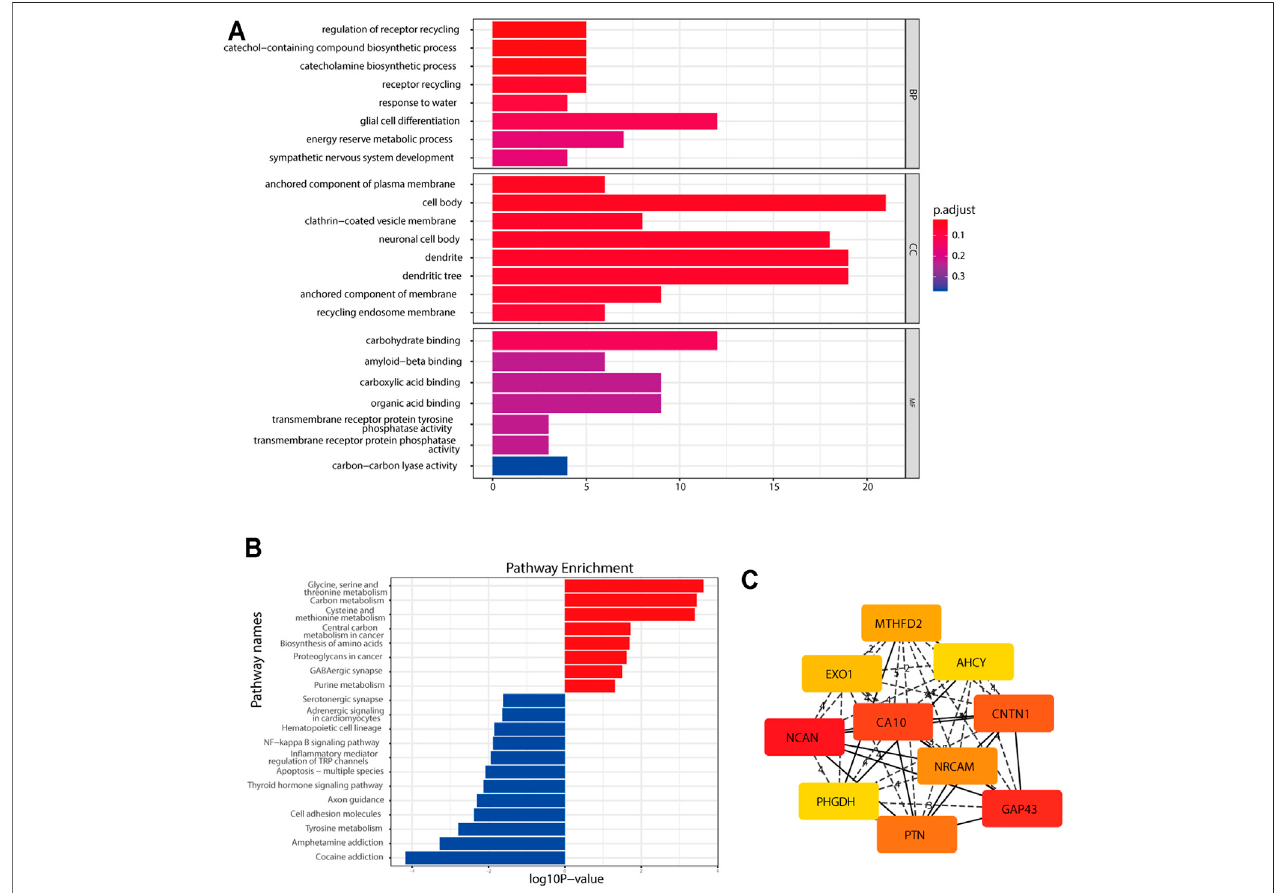
FIGURE3 | Functional enrichmentanalysis ofthe DEGs. (A) GOanalysisof theDEGs. (B) KEGG pathway enrichment analysis ofthe DEGs. (C) Top 10 hub genes found by the CytoHubba plugin in Cytoscape software through the MCC method.